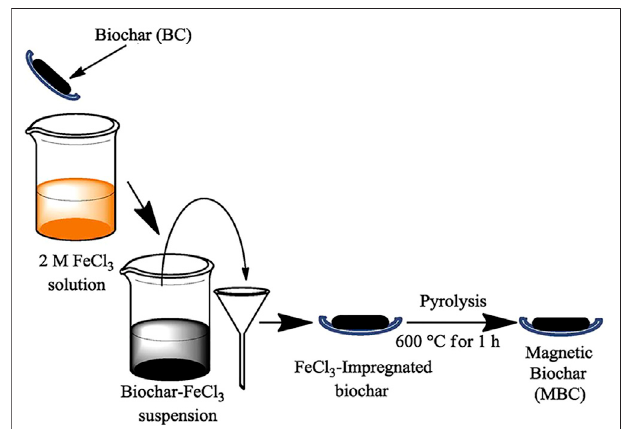
FIGURE 8 | Preparation of magnetic biochar by impregnation and subsequent calcination (Bombuwala Dewage et al., 2018).